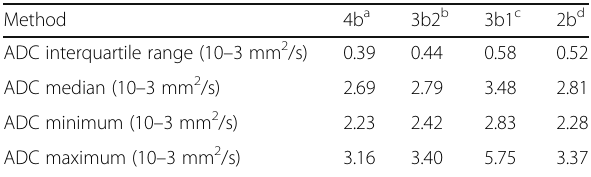
Table 2 ADC values of healthy liver parenchyma in rats ( n = 18) calculated from different b value combinations